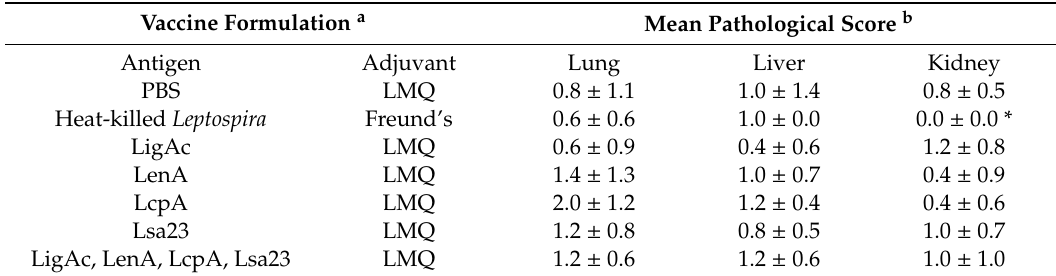
Table 2. Pathology score conferred by immunization with vaccines in hamsters.